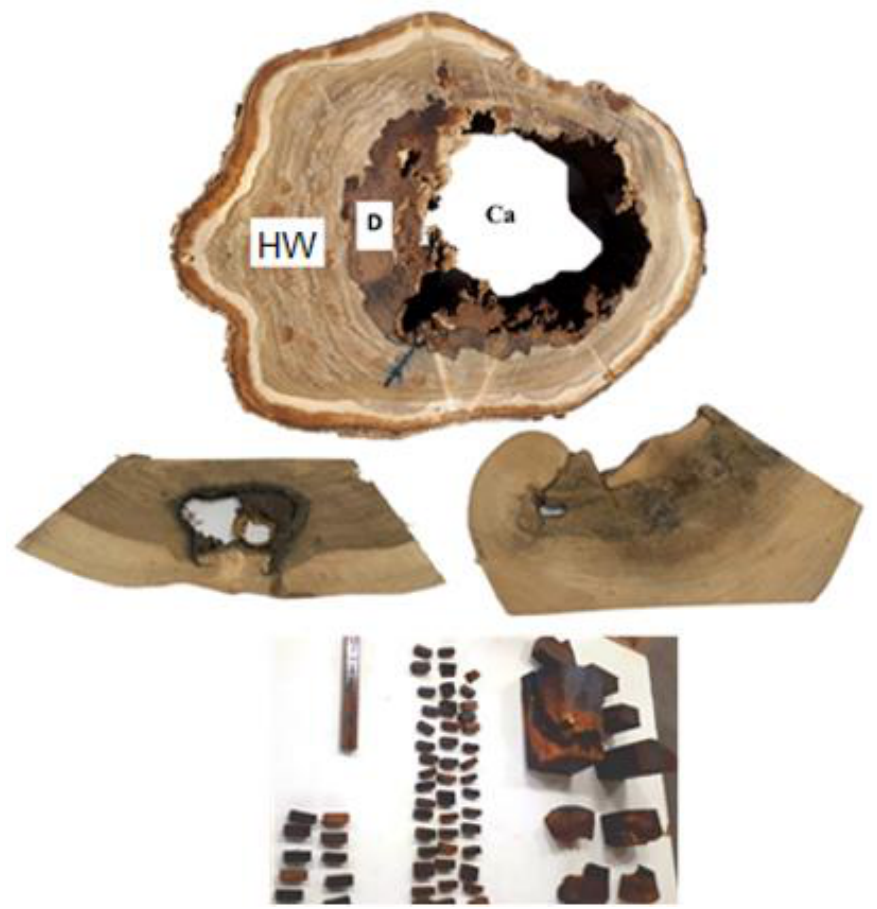
Figure 4. Upper image : Cross-sections after polishing showing demarcation of the healthy wood regions (HW), deteriorated wood (D) and cavity (Ca); Intermediate image : cross-section cuts in different demarcated regions; lower image : specimens taken from different demarcated regions.